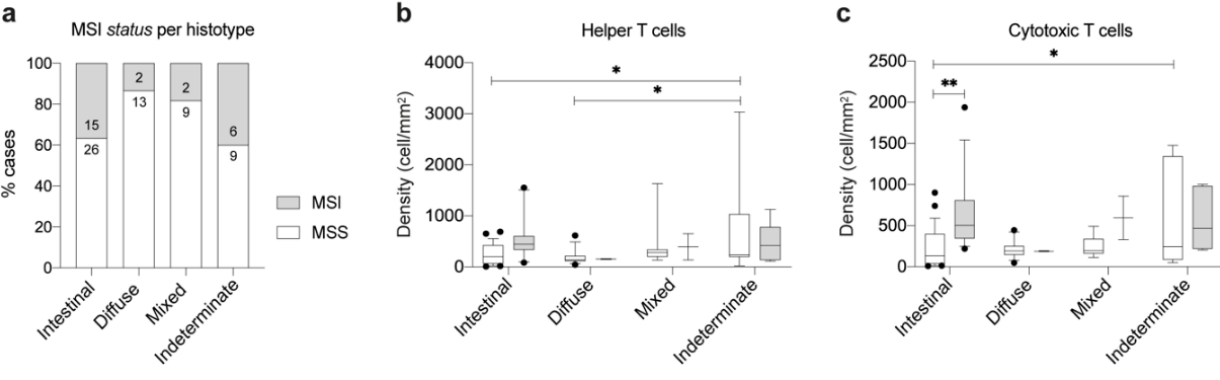
Figure 2. Distribution of T cell populations in MSS and microsatellite instability (MSI) GC tumors. ( a ) Relative and absolute frequency of MSS and MSI cases for each GC histological type. ( b – f ) Relative numbers of helper ( b ), cytotoxic T cells ( c ), Tregs ( d ), and Tregs normalized to helper T cells ( e ) and cytotoxic T cells ( f ), according to the MSI status and tumor histology. ( g , h ) Relative number of Tregs normalized to cytotoxic and helper T cells within the stroma ( g ) and tumor nest ( h ) areas of intestinal-type GC cases, according to MSI status. Relative number of Tregs, cytotoxic T cells, and helper T cells within the stroma ( i ) and tumor nest ( j ) areas of intestinal-type GC cases, according to MSI status. See Supplementary Figure S1 for a visual description of stroma and tumor nest areas. Box and whiskers represent median ± 10 to 90 percentile. * p < 0.05, ** p < 0.01, *** p < 0.001, **** p < 0.0001. Two-way ANOVA with Tukey’s/Sidak’s multiple comparisons test ( b – f ) and Mann–Whitney U test ( g – j ).